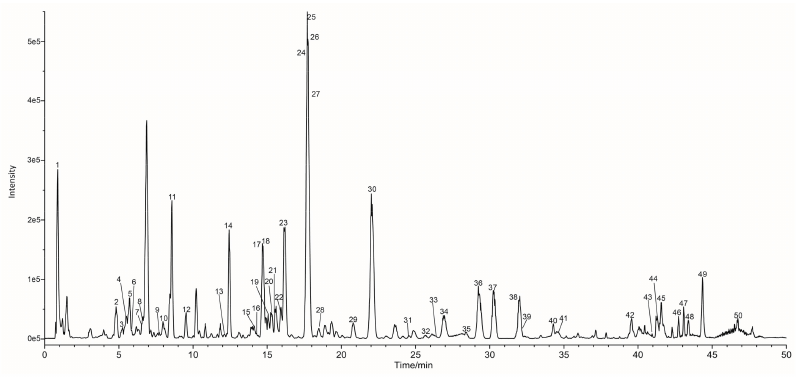
Figure 1. Base Peak Chromatogram (BPC) in negative mode of